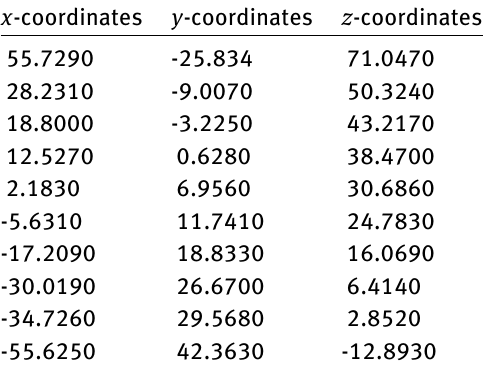
Table 5: 3D point cloud from [31, p.64]